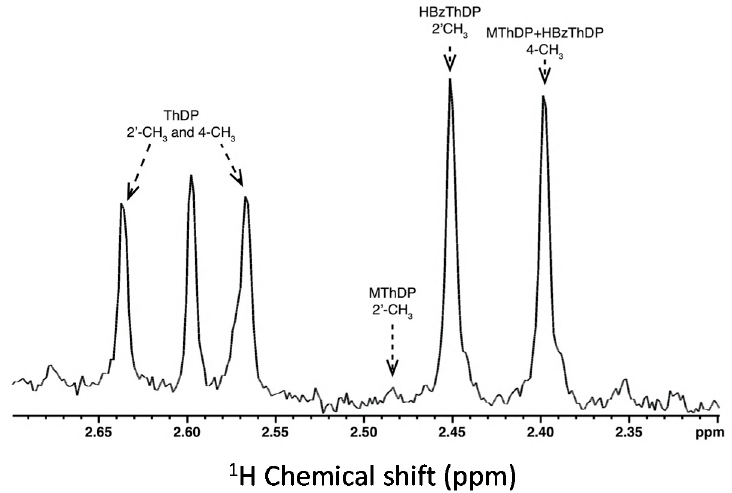
Figure 1. The 2 ′‐ CH 3 and 4 ‐ CH 3 singlet signals of thiamin diphosphate (ThDP) and of benzoylformate ‐ conjugated covalent intermediates were used for the assignment and quantitative analysis of the following intermediates: ThDP (2.64 and 2.57 ppm), mandelyl ‐ ThDP (MThDP) (2.48 and 2.41 ppm), and 2 ‐ hydroxybenzyl ‐ ThDP (HBzThDP) (2.45 and 2.40 ppm). Intermediates and cofactor were isolated from the protein by acid quench after a reaction time of 1 s and analyzed by 1 H NMR at pH 0.75 at 25 °C as described in Materials and Methods. Relative concentrations of intermediates were determined from the relative integrals of the corresponding signals, which were used to calculate all microscopic rate constants of the catalytic cycle.